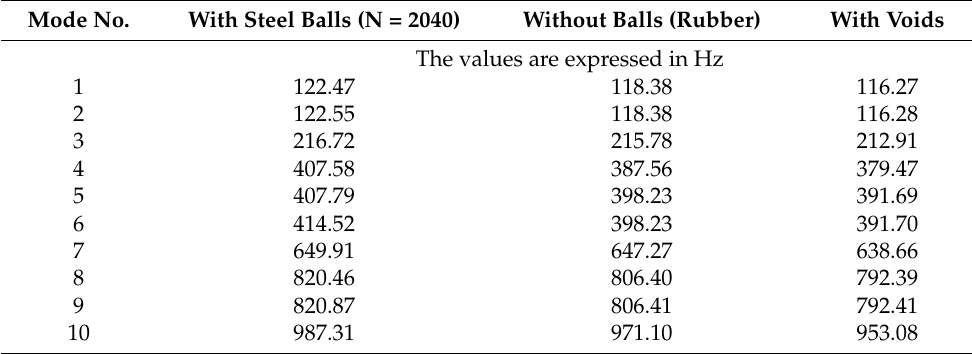
Table 4. The eigenpulsations for three different cases (N = 2040).